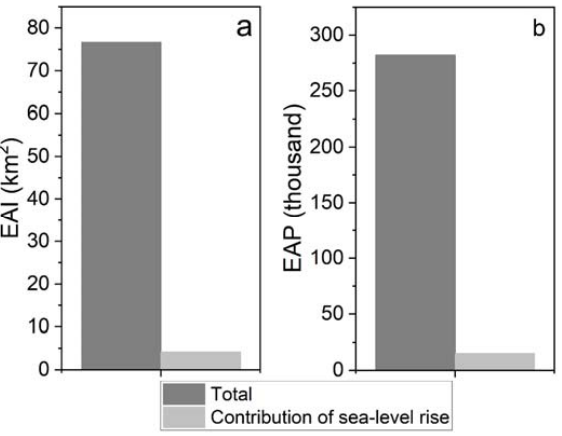
Figure 10. Extra impacts of a future 10 cm sea-level rise on coastal flooding. ( a ) Expected annual inundation (EAI), and ( b ) expected annual population (EAP) exposed to coastal flooding in 2035.